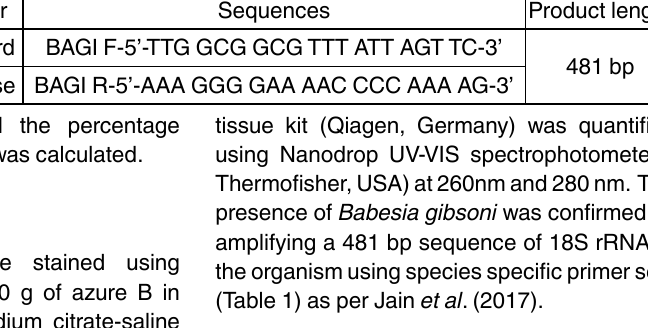
table 1 . Species-specific primer sequences of Babesia gibsoni organisms Organism